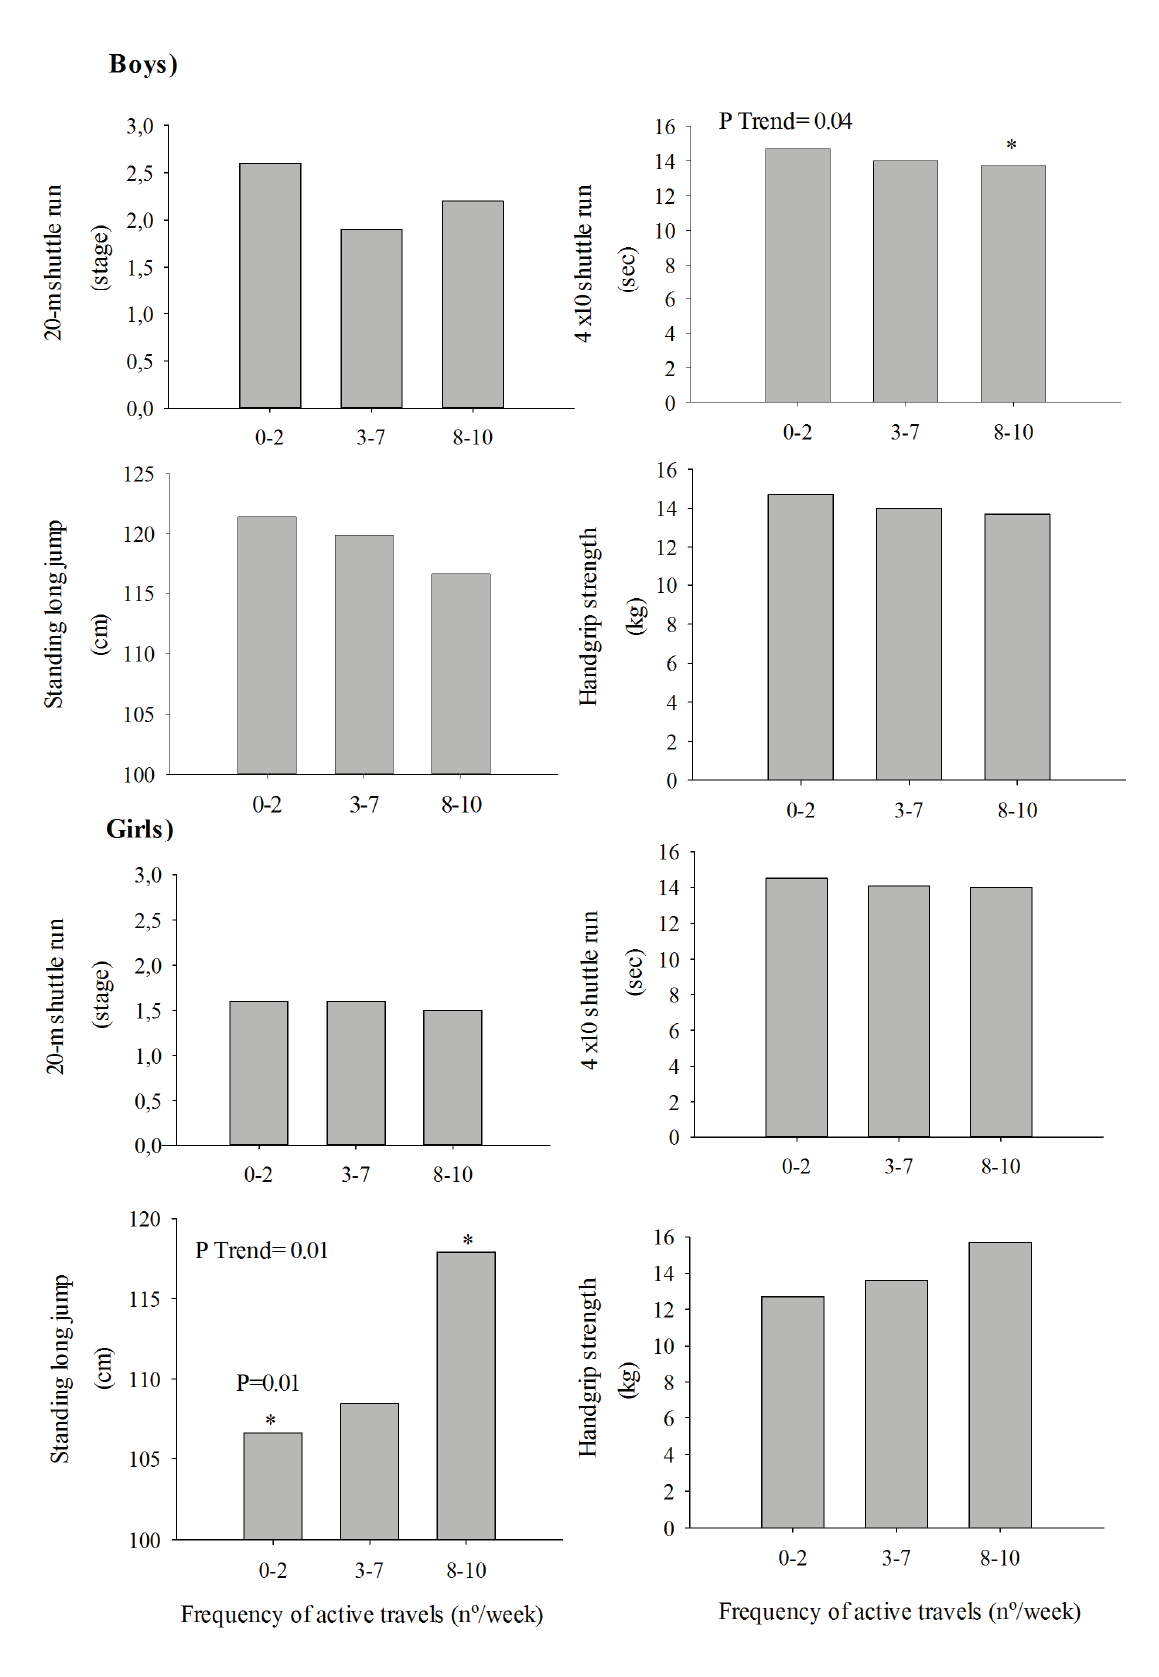
Figure 1. Association between active commuting to school and fitness tests, adjusting for age, BMI, and distance, from home to school for boys and